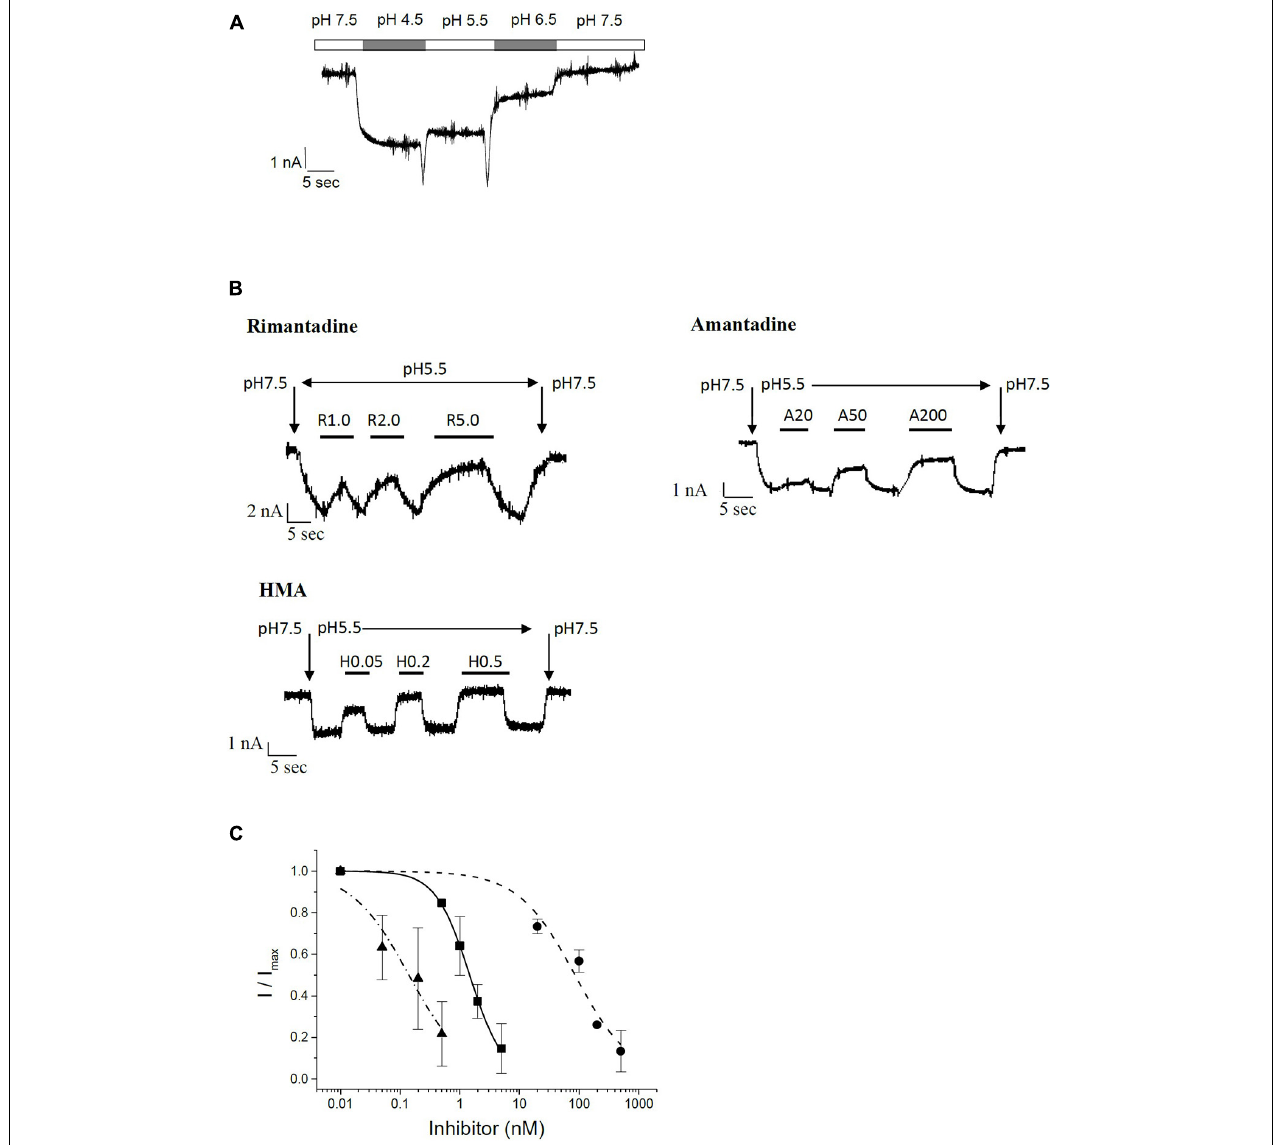
FIGURE 4 | Patch clamp electrophysiology on recombinant SARS CoV E protein in HEK293 cells. (A) pH-dependent currents in permeant ion-minimized extracellular buffer (in mM: 90 N-Methyl-D-glucamine (NMDG), 3 CaCl 2 , 90 HEPES and 90 MES). Cells in the whole-cell configuration were perfused with buffer of the indicated pH, as indicated by bars above the trace. Here, lower pH defines a higher concentration of permeant protons, which leads to increased currents. (B) Inhibition of E channel-mediated currents by rimantadine, amantadine and HMA in minimized extracellular buffer. Baseline was measured at pH 7.5, reduction in pH to pH 5.5 resulted in an E protein-mediated inward current that could be inhibited by test compounds. At the end of each measurement, pH was switched back to control (7.5). Vertical arrows indicate switch to buffer with indicated pH. Bars denote flow application of indicated concentrations of inhibitor. (C) Summary of IC 50 curves. Solid squares, solid line: rimantadine; solid circles, short-dashed line: amantadine; solid triangles, dash-dotted line: HMA.